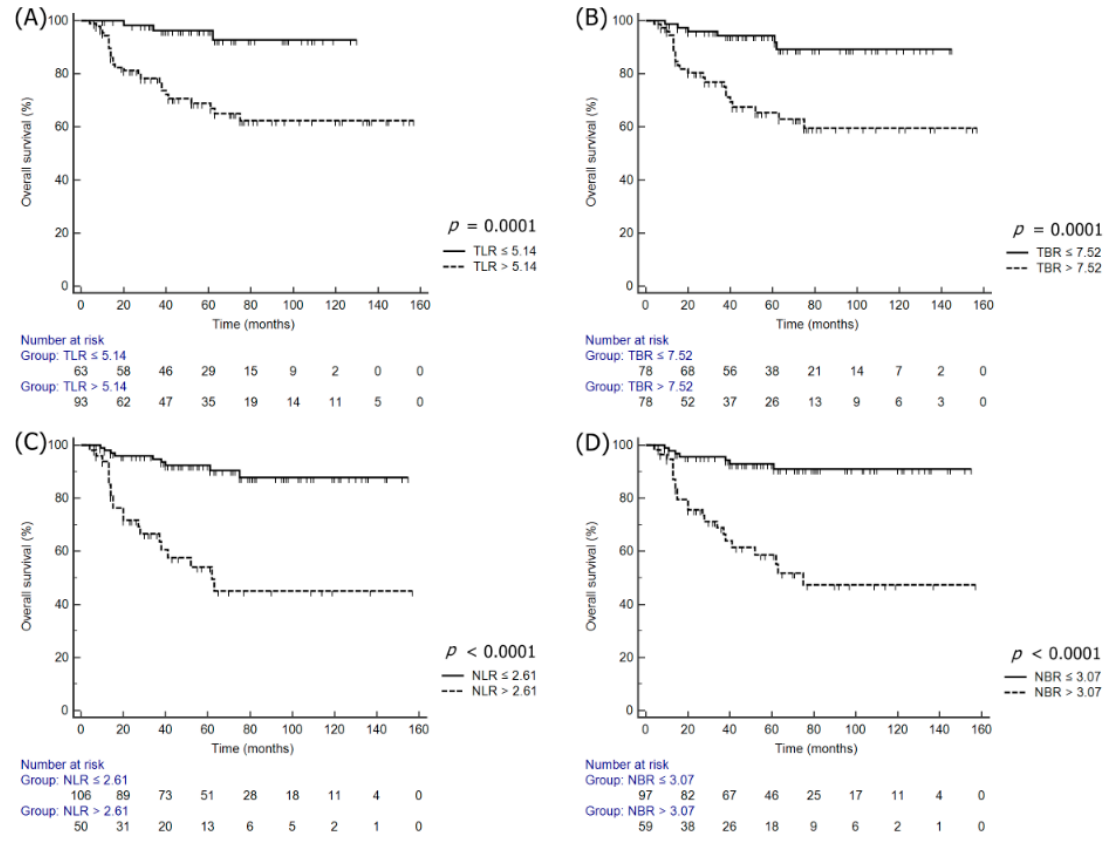
Figure 2. Kaplan–Meier survival plots of OS according to the normalized tSUV max and nSUV max to the liver or blood: ( A ) TLR, ( B ) TBR, ( C ) NLR, and ( D ) NBR. Table 3. Multivariate analyses of PET parameters in relation to DFS and OS after adjusting for clinicopathologic factors.